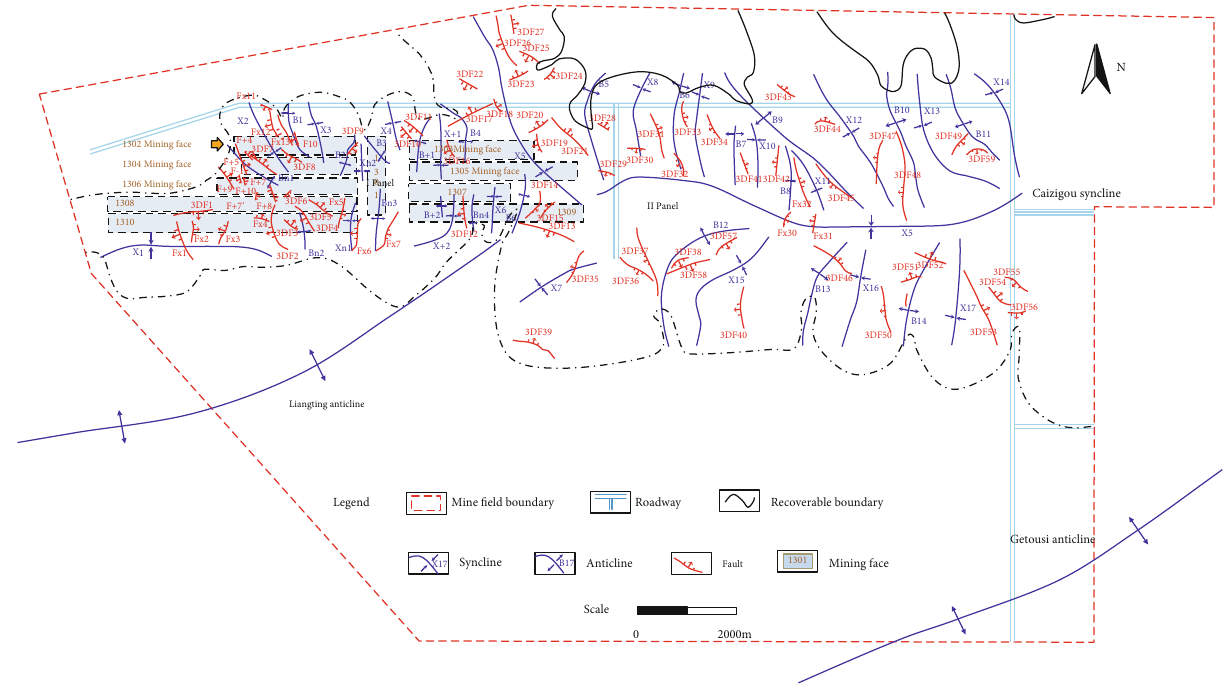
Figure 1: Geological and tectonic features of the study